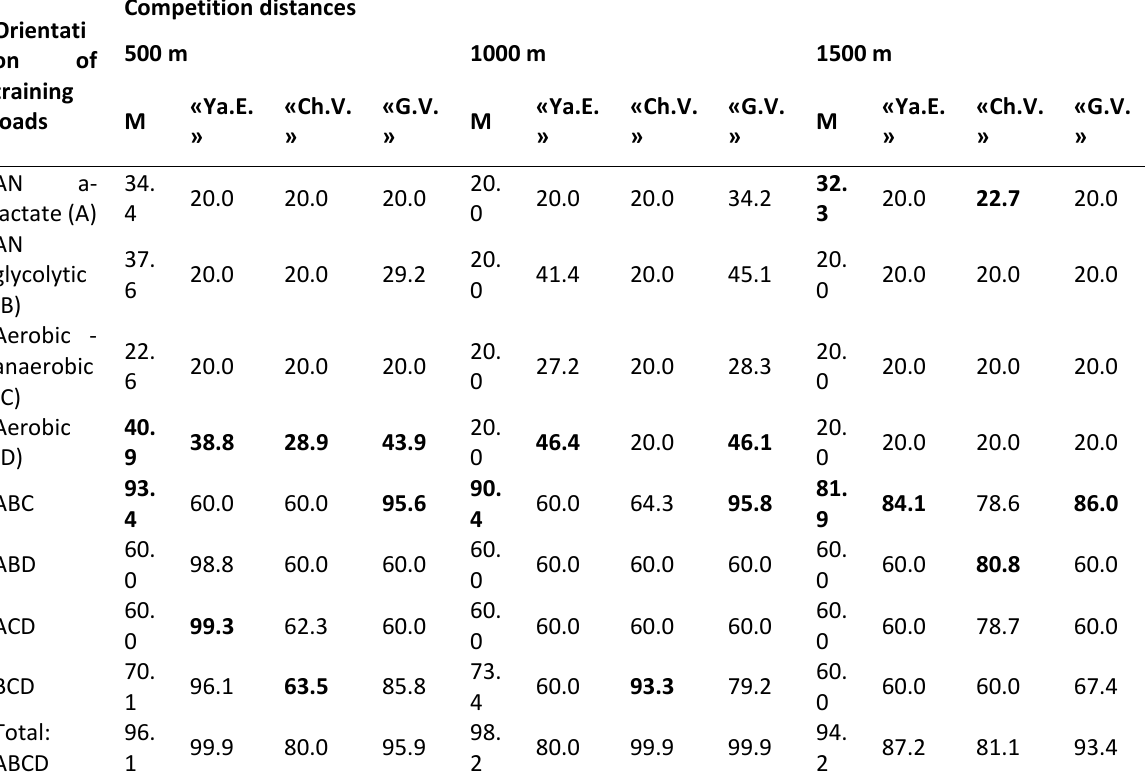
Table 1. Influence of cyclic loads of different physiological orientation on averaged and individual sport results’ dynamic of leading short trackers of Ukraine in 2000–2006 (r 2 ,%) Orientati